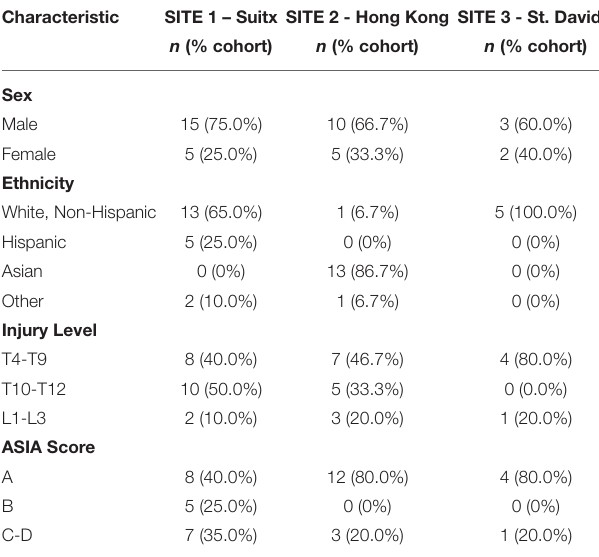
TABLE 4 | Patient characteristics and